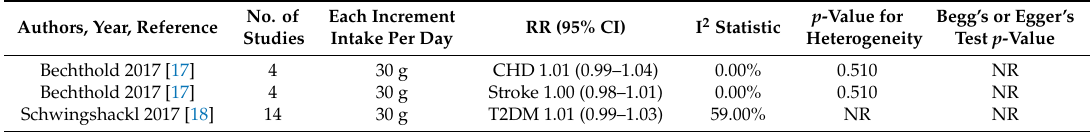
Table 12. Summary of linear dose-response meta-analyses of prospective studies on refined grain intake and CHD, stroke,